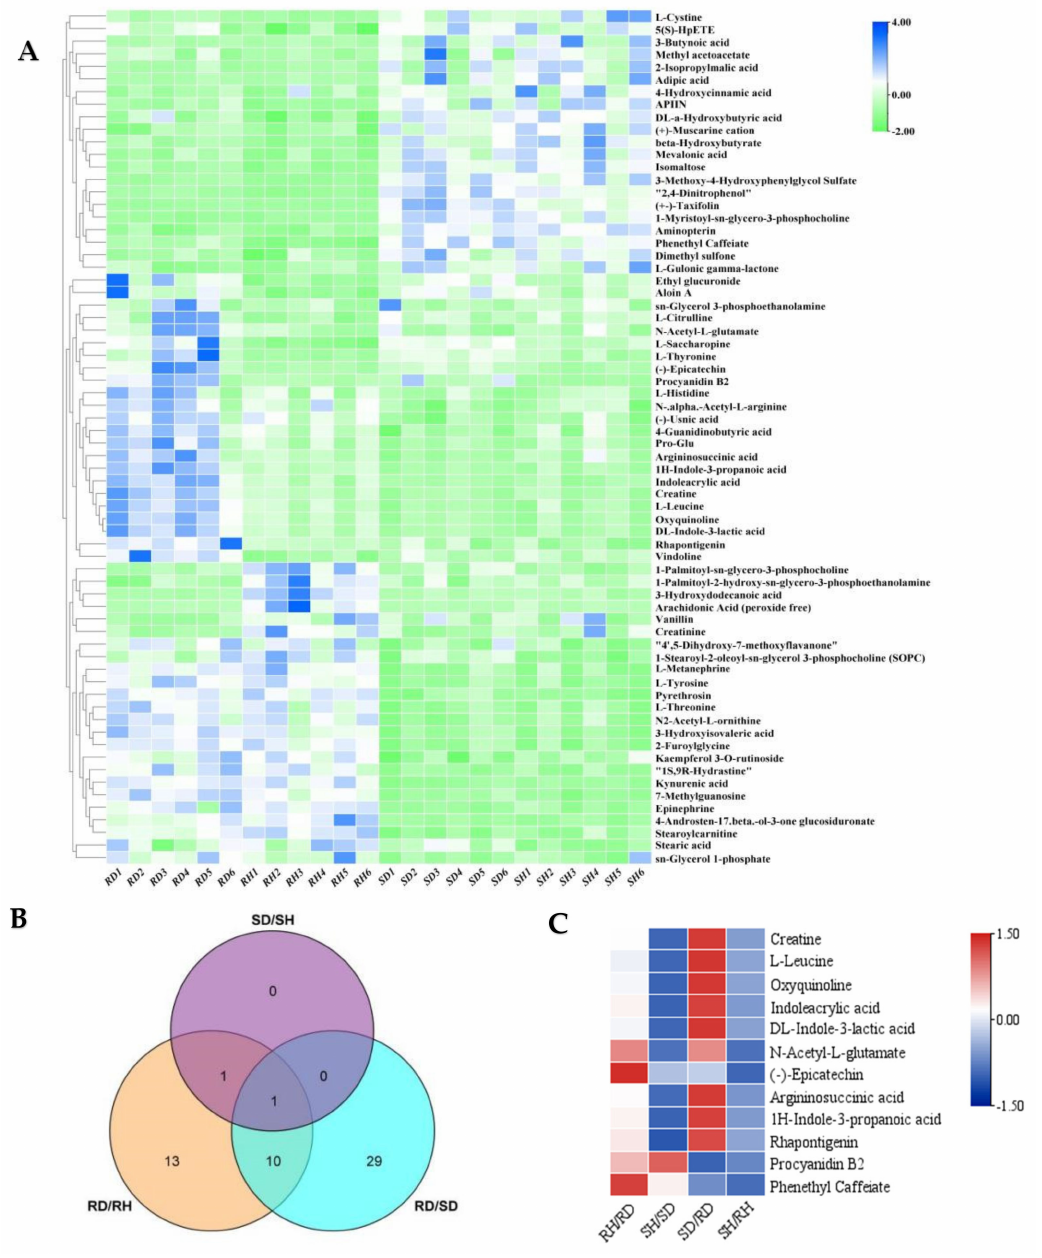
Figure 4. ( A ) Heat map of 68 differentially accumulated metabolites (DAMs), data of each row was standardized. ( B ) Venn diagram showing DAMs shared among RD/RH, SD/SH and RD/SD. ( C ) Heat map of fold changes of 12 DAMs in four pairwise comparsions, data of each row was